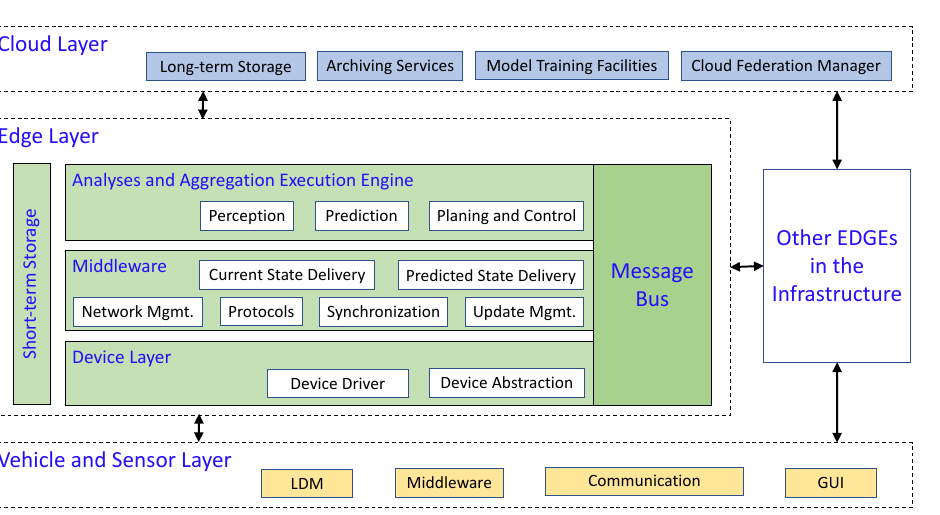
Figure 3. An overview of the Edge architecture for CCAM